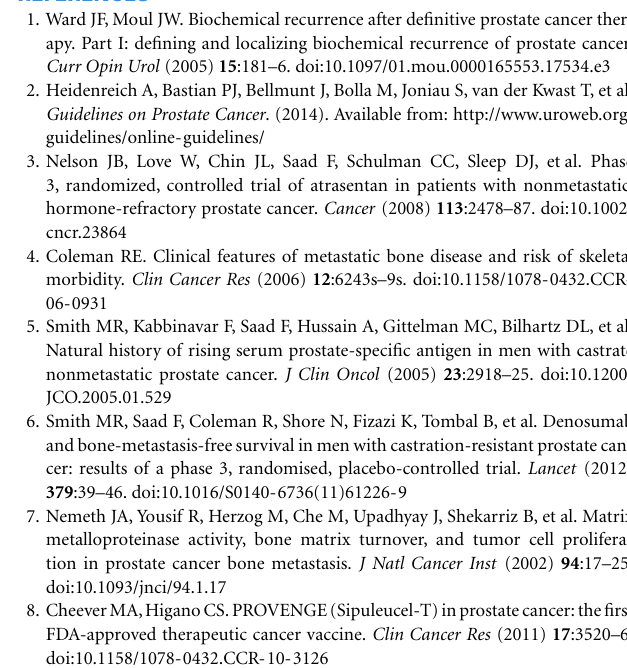
influenced by disease or treatment factors that were not evaluated in our chart